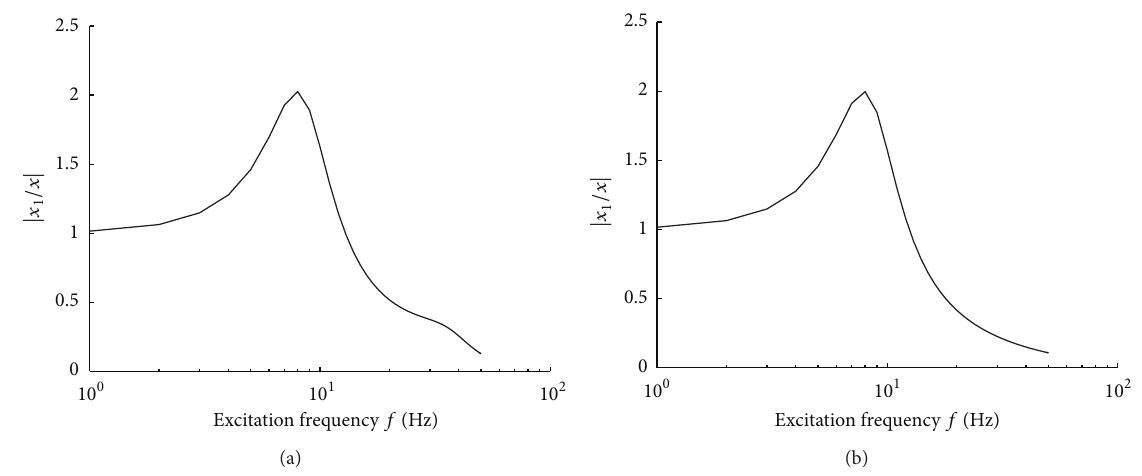
Figure 14: (a) Amplitude-frequency characteristic when 𝑚